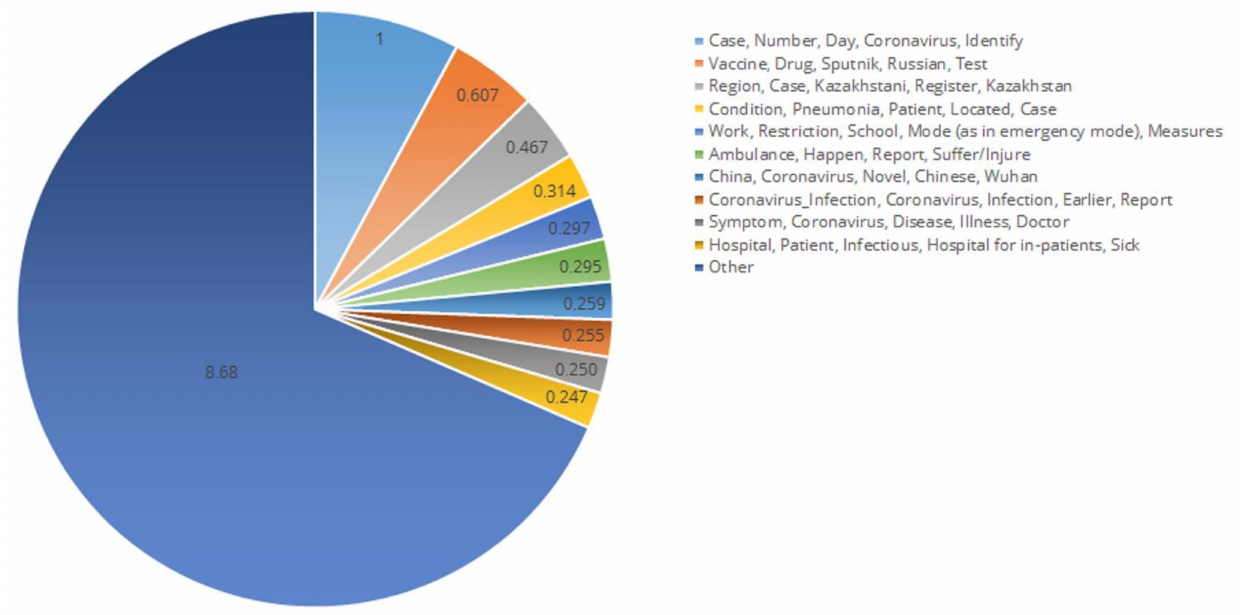
Figure 3. Distribution of topics by relative volume in the second level of the thematic